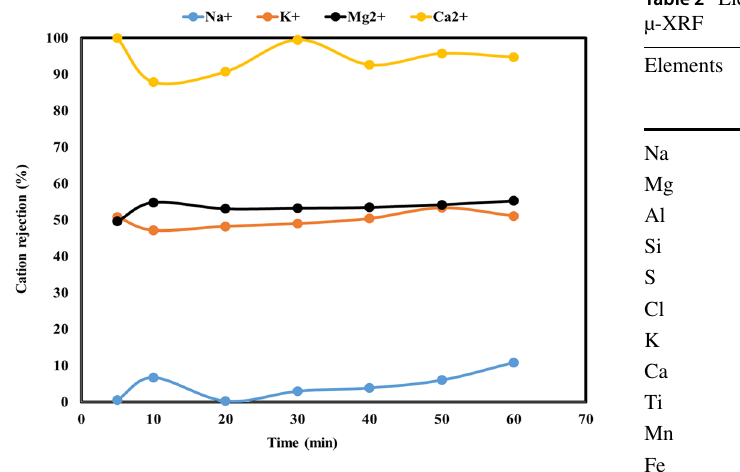
Fig. 11 Cation rejection of filter cake containing pure bentonite